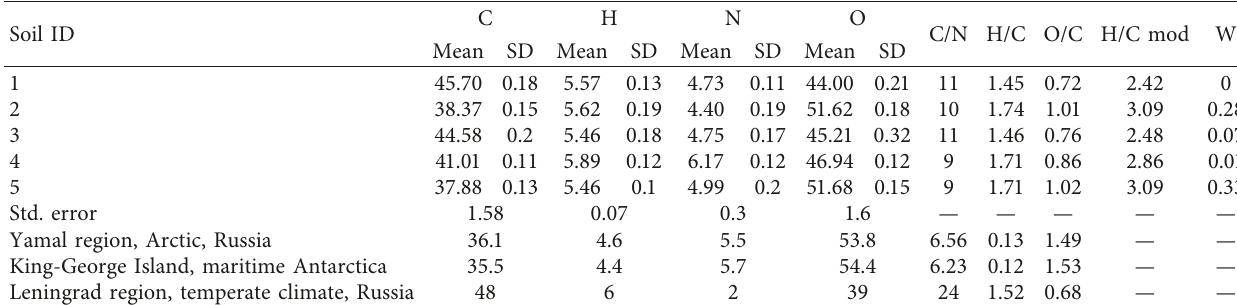
Table 2: Elemental composition of the studied